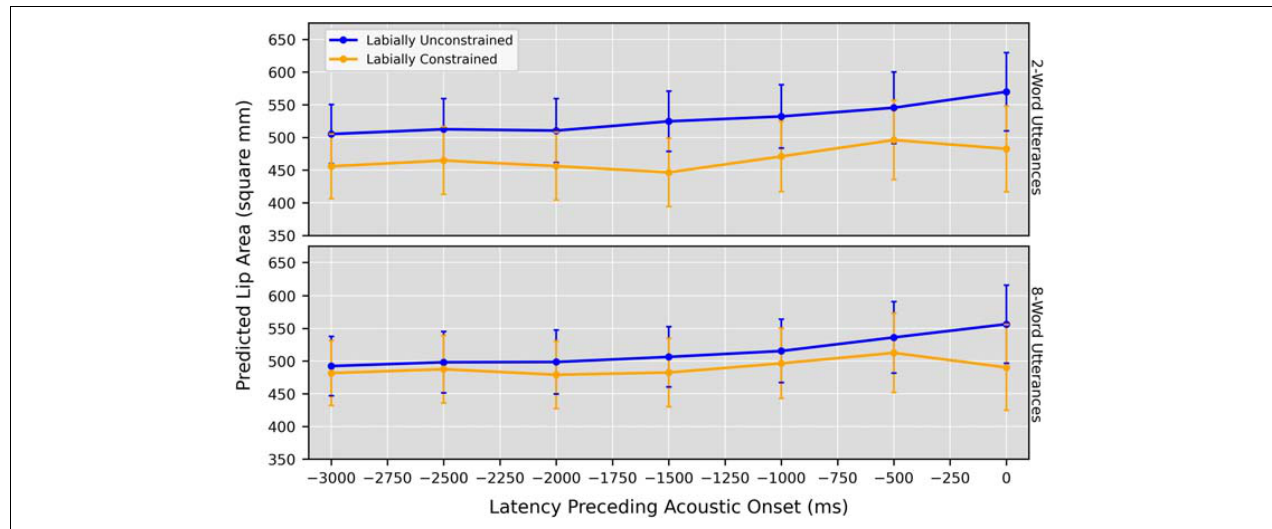
FIGURE 3 | Predicted lip area values produced by the linear mixed models, when setting the word count predictor to 2 words and 8 words. Models were fit to junctures at 15-frame (500-ms) intervals, starting at 90 frames (3,000 ms) preceding acoustic onset. Error bars: Bootstrapped 95% CI.